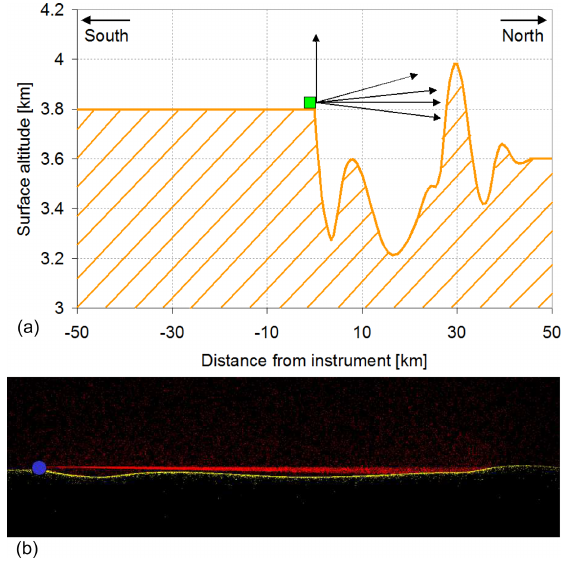
Figure 3. (a) Variation in the surface altitude in the viewing direc- tion (towards the north). The variation in the surface altitude across the viewing direction was not explicitly considered to minimize the computational effort. For the same reason, the topography “behind” the instrument towards the south was also assumed to be flat. (b) Il- lustration of the results of the radiative transfer simulations for the area between the instrument and the high mountain 30km away. The blue dot indicates the position of the instrument. The small red and yellow dots indicate Rayleigh-scattering events and surface re- flection of the simulated solar photons, respectively.